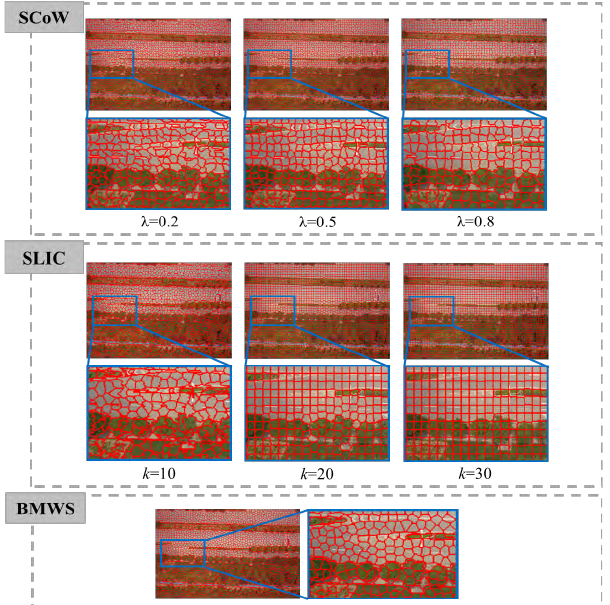
Figure 3. Comparison of compactness and adherence of superpixels algorithm. The parameters λ and k are used to adjust the compactness (regularity) of superpixels.